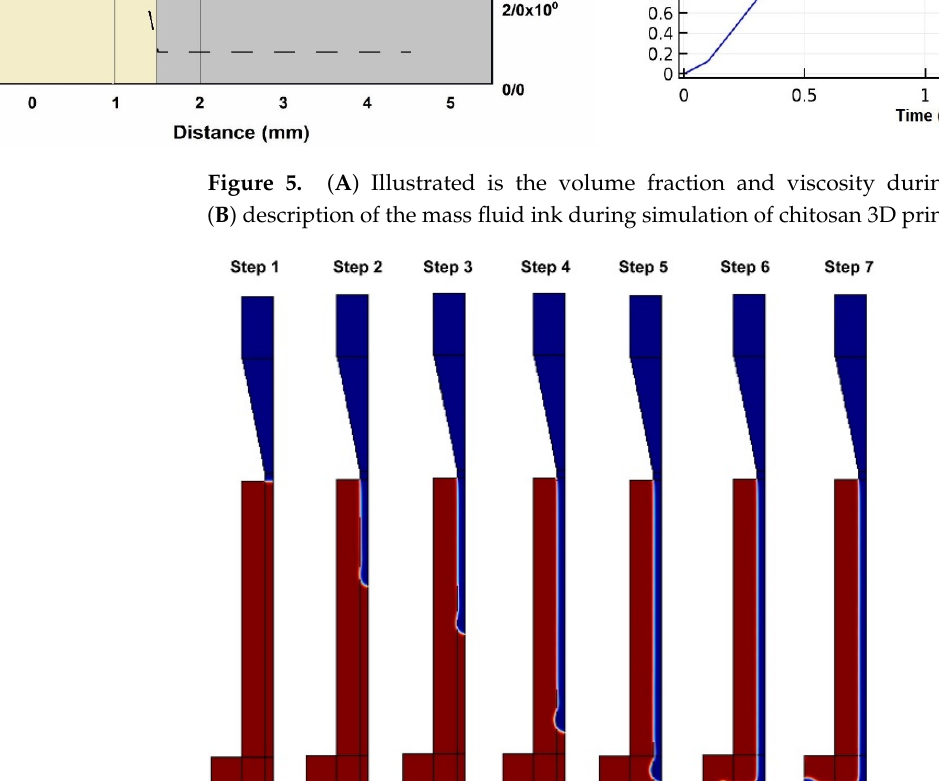
Figure 5. ( A ) Illustrated is the volume fraction and viscosity during chitosan 3D printing; ( B ) de- scription of the mass fluid ink during simulation of chitosan 3D printing.